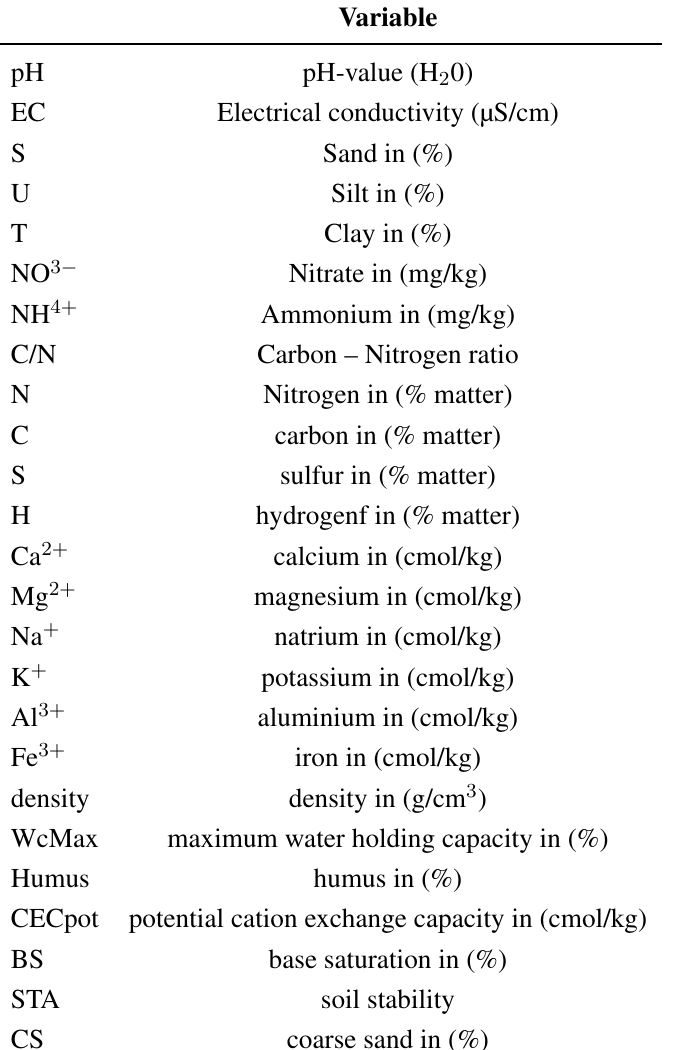
Table A1. All 28 soil parameters used for clustering and NMDS ordination are listed in this